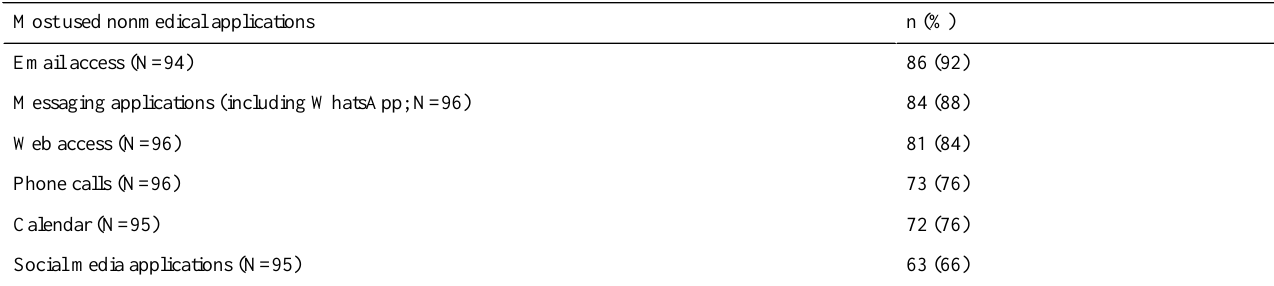
Table 4. The most used nonmedical applications.